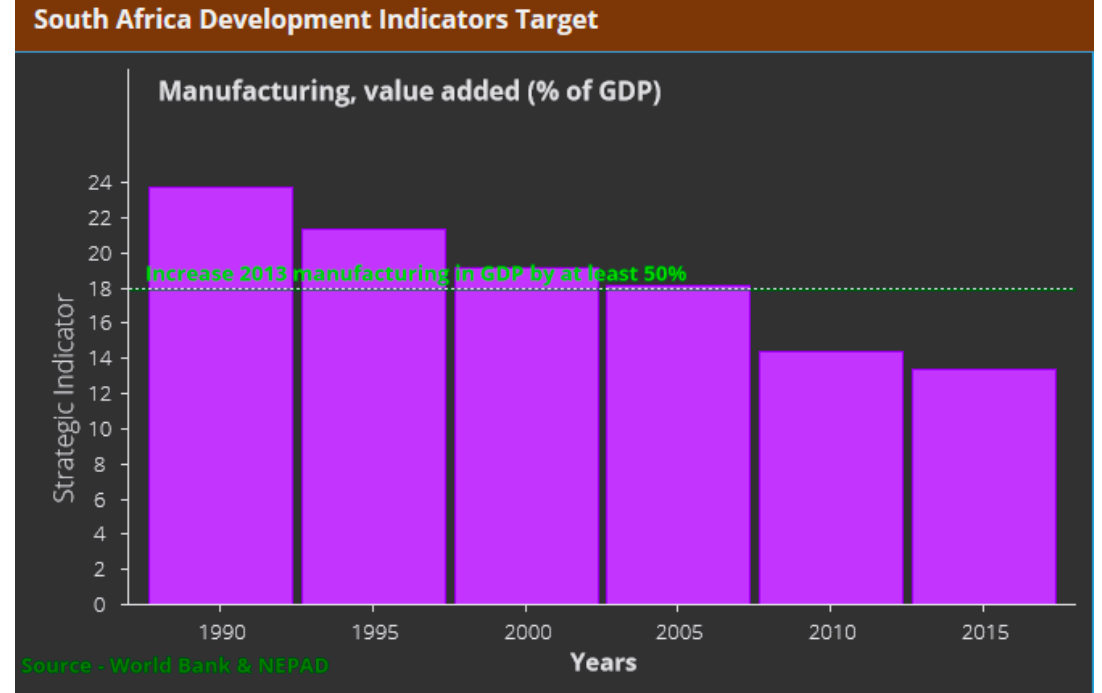
Figure 13. Manufacturing, value-added information displayed by the front end.